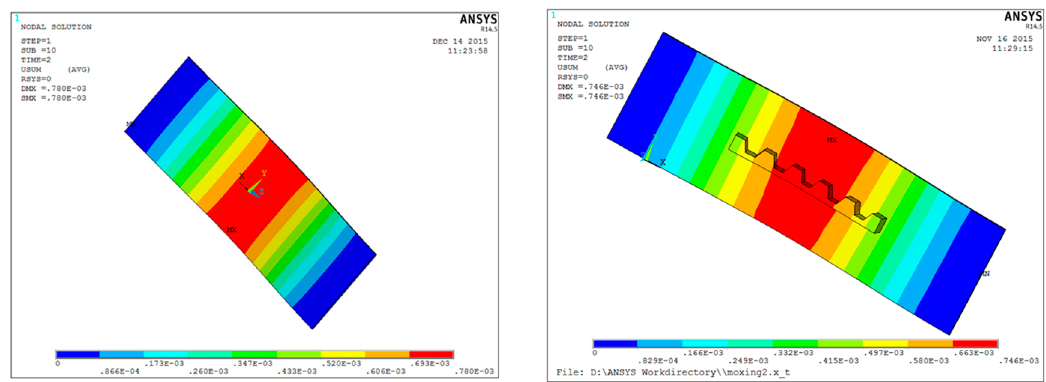
Figure 7. Strain distribution of the beam structure with ( left ); and without ( right ) cell-holding device.